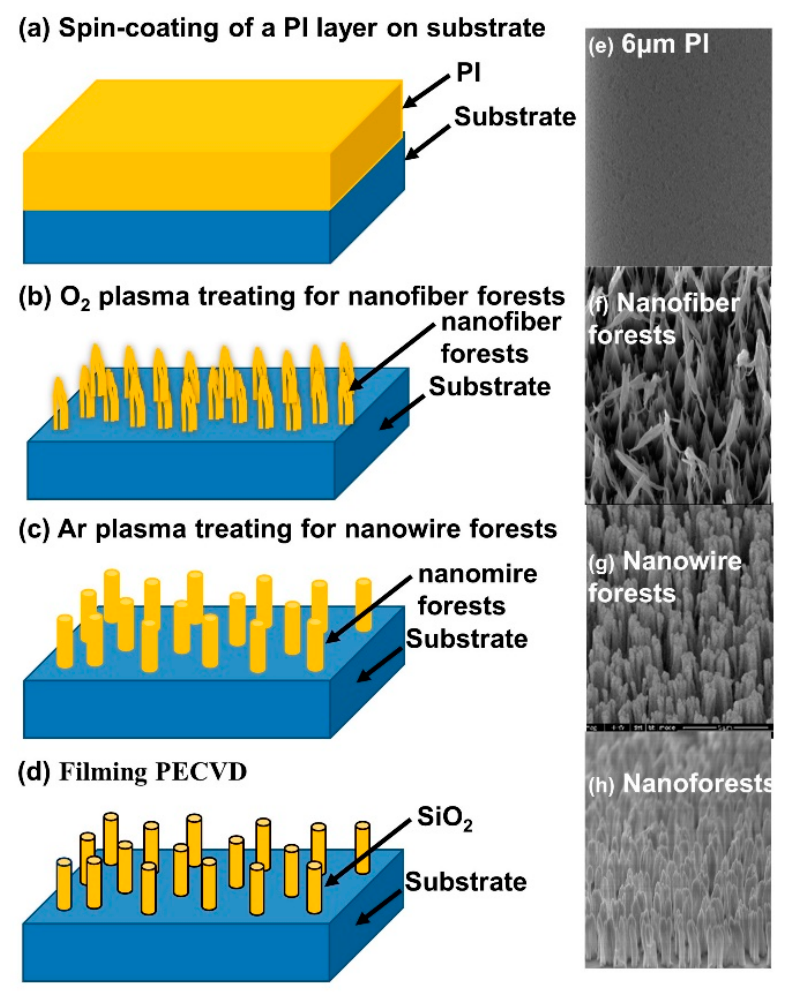
Figure 2. Illustration of the preparation for nanoforest structure: ( a ) process of spin-coating polyimide photoresist; ( b ) O 2 plasma treatment for nanowire forests; ( c ) Ar plasma treatment for nanowire forests; ( d ) process of SiO 2 coating by PECVD; ( e – h ) SEM images of the PI layer, nanofiber forests, nanowire forests, and nanoforests.